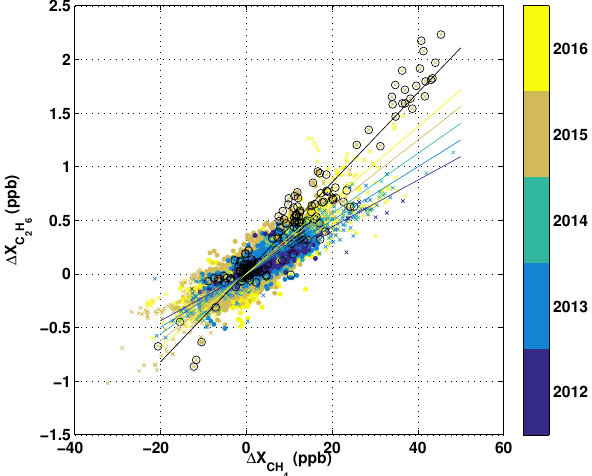
Figure 9. This figure shows the ethane and methane anomalies dur- ing the Caltech TCCON record. The entire time series is represented by filled circles, the plume data are represented by “x” symbols, and the measurements of the plume originating from the Aliso Canyon gas leak are circled in black. The colours represent the year dur- ing which the measurements were recorded. The average ambient slopes from Fig. 7 are indicated with solid lines and show a time dependence consistent with the slopes from plumes. The ethane to methane slope in the Aliso Canyon plume data (black line) shows a high degree of correlation ( R 2 = 0 . 95) and a slope of 4 . 28 ± 0 . 07%. Note that the ethane to methane ratios in the ambient air were rising throughout the